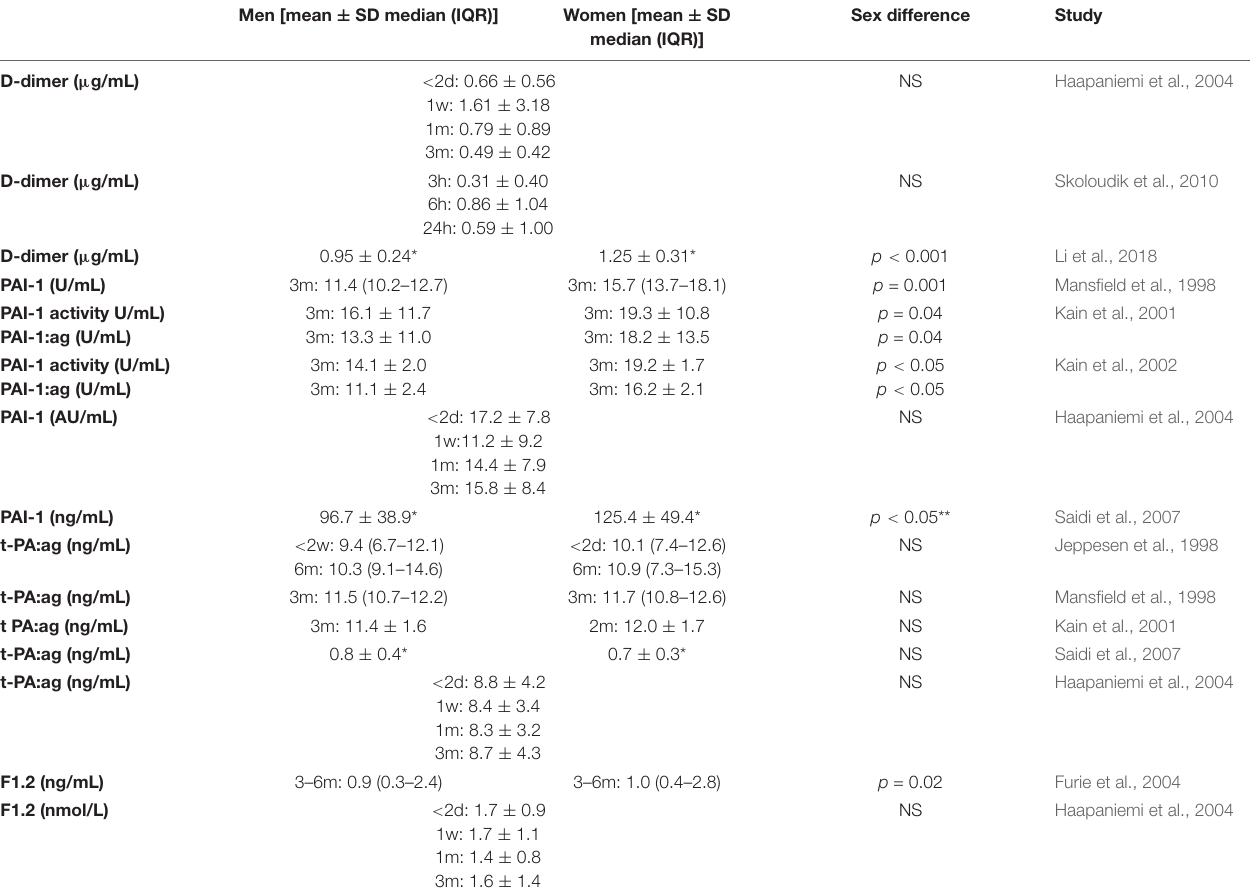
TABLE 3 | Fibrinolysis factors. Men [mean ± SD median (IQR)] Women [mean ± SD